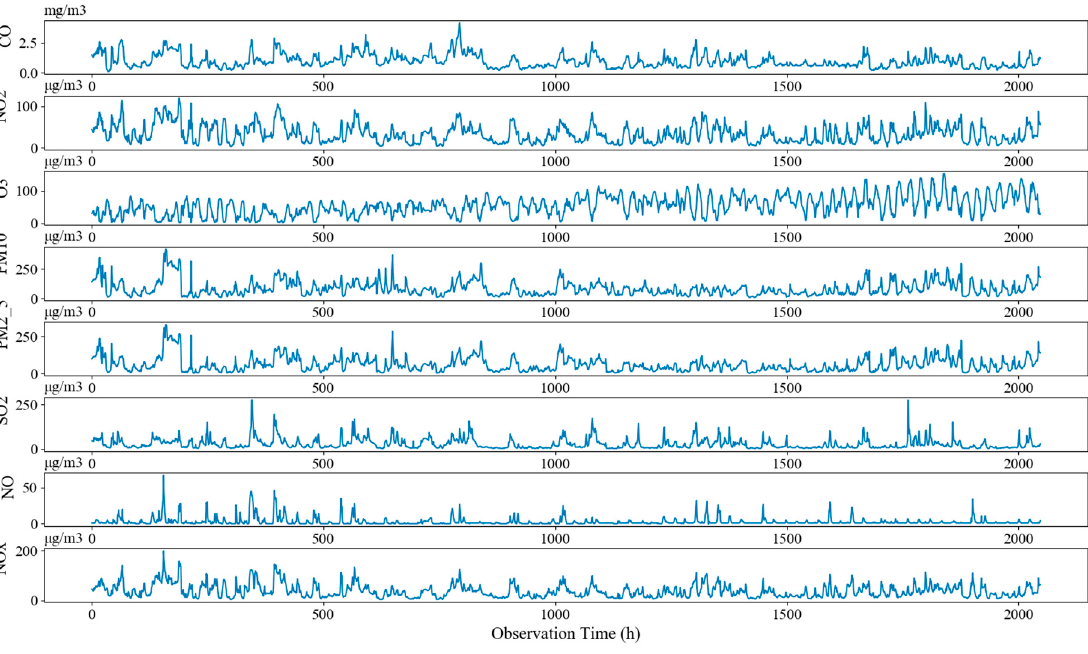
Figure 4. The fluctuation of air pollutant concentration trends. This figure shows the hourly concentration fluctuation for eight major pollutants at one monitoring site in Shenyang (from January 1st 2017 to March 31st